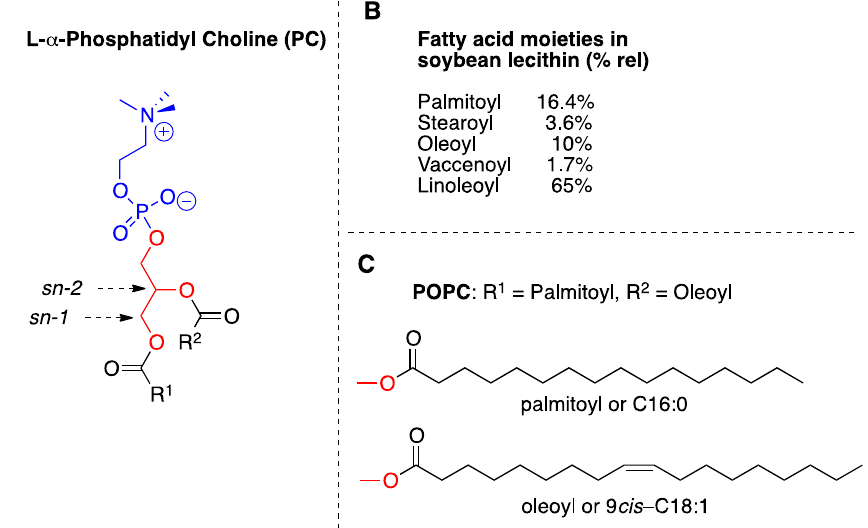
Figure 2. Lipid structures: ( A ) L - α -phosphatidyl choline (PC) general structure; ( B ) list of fatty acids present in soybean lecithin and the relative percentages obtained from the gas chromatographic analysis; ( C ) the structures of palmitic acid and oleic acid present in 1-palmitoyl-2-oleoyl phosphatidyl choline (POPC).